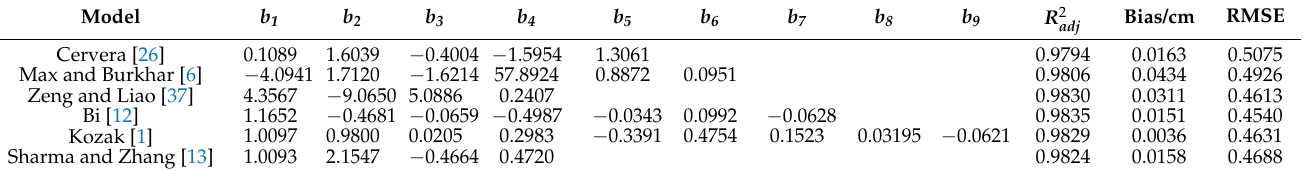
Table 3. Fit parameters and statistics of six selected